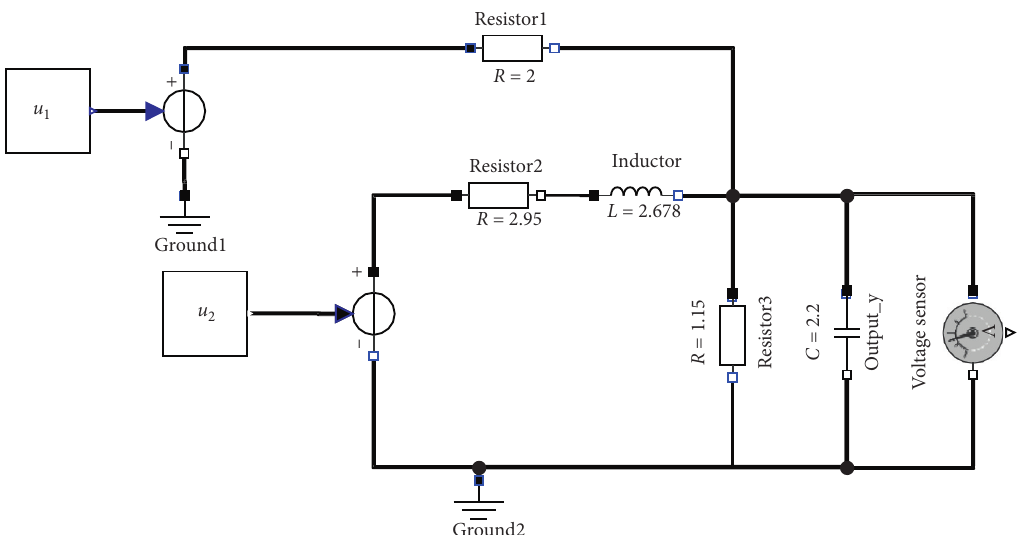
Figure 7: System schematic diagram with two modified inputs signals u across the capacitor 2 . 2F, and the circuit is simulated with Wolfram SystemModeler software for simulation